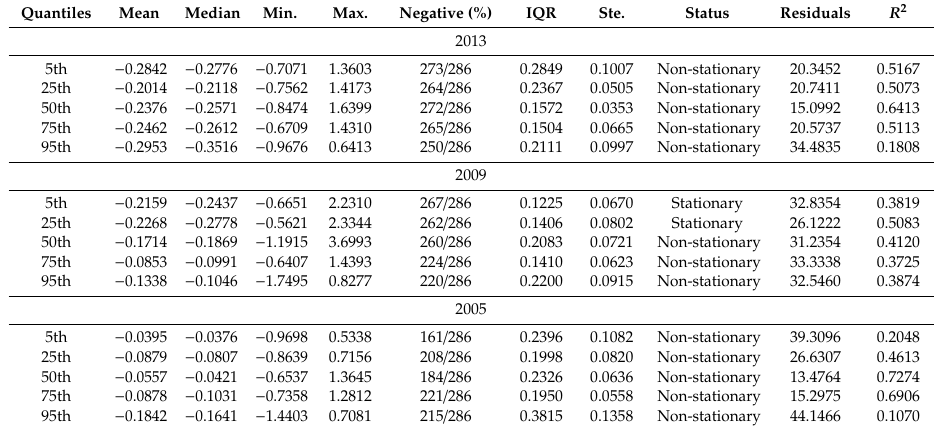
Table A2. Summary statistics of GWQR (AIC method) estimate coe ffi cients of PM2.5 for 2005–2013. Quantiles Mean Median